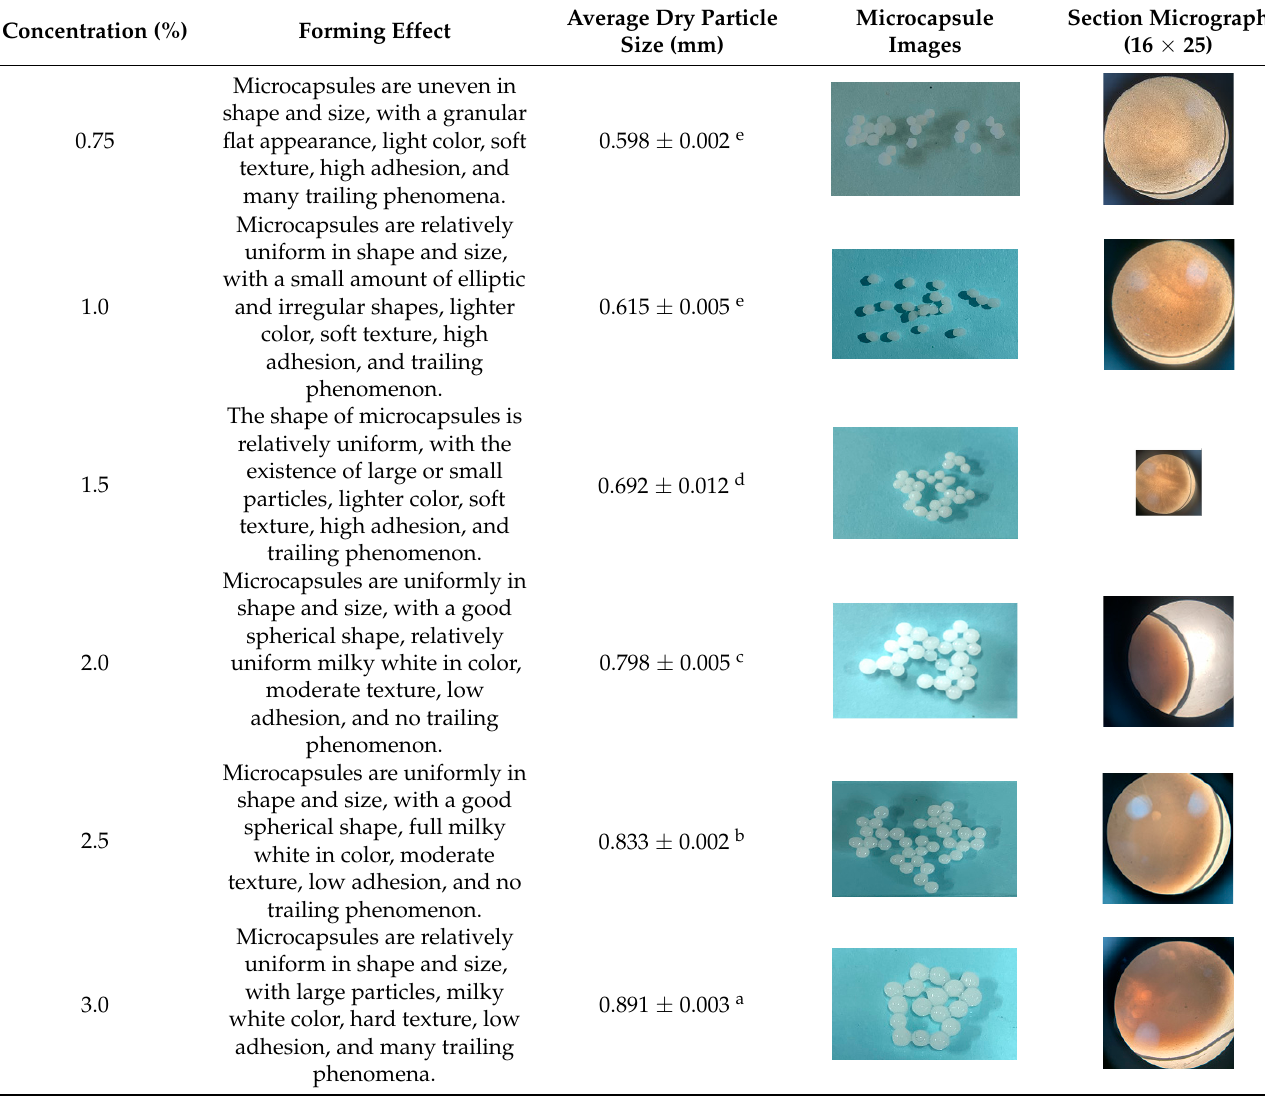
Table 1. Effect of SA Concentration on microcapsule formation.